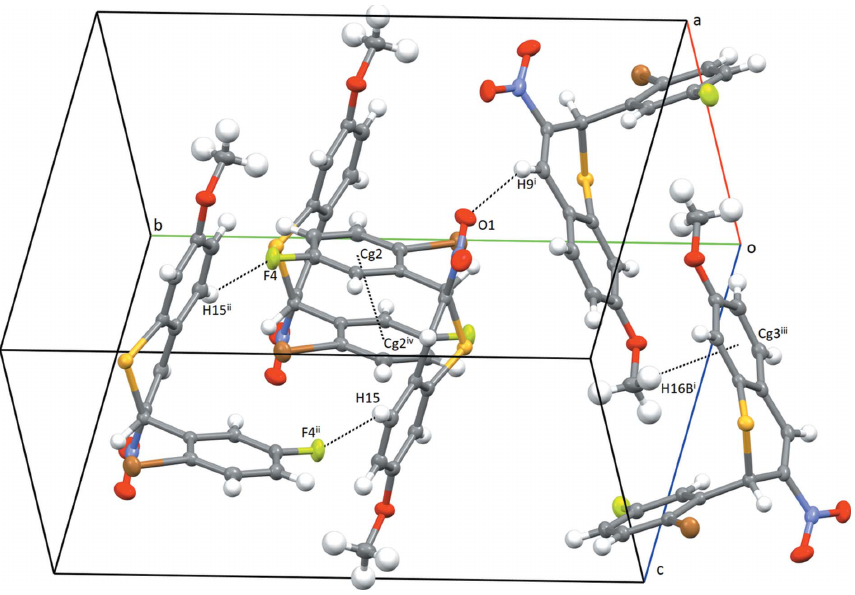
Figure 4 Packing diagram for B , showing C—H (cid:2)(cid:2)(cid:2) O, C—H (cid:2)(cid:2)(cid:2) F, C—H (cid:2)(cid:2)(cid:2) (cid:2) and (cid:2) – (cid:2) interactions [symmetry codes: (i) x , (cid:5) y + 1 , z (cid:5) 1 ; (ii) (cid:5) x + 2, (cid:5) y + 1, (cid:5) z + 2; 2 2 (iii) (cid:5) x + 1, y (cid:5) 1 , (cid:5) z + 3 ; (iv) (cid:5) x + 1, (cid:5) y + 1, (cid:5) z + 1]. Cg 2 and Cg 3 are the centroids of the C1–C6 and C10–C15 rings, respectively. 2 2 0.5111 (18) A˚ , (cid:3) = 118.2 (2) (cid:3) and ’ = 208.1 (3) (cid:3) for B ]. The lengths in compound B [1.232 (2) and 1.221 (2) A˚ ] are slightly C—S bond lengths are almost equal [C7—S1 = 1.828 (4) A˚ longer than those in compound A [both 1.219 (5) A˚ ]. The nitro and C11—S1 = 1.8307 (19) A˚ for A , and 1.758 (5) and 1.7574 (19) A˚ for B , respectively]. The C11—S1—C7 bond the torsion angle O2—N8—C8—C9 of 1.3 (7) (cid:3) in A and angle is 102.5 (2) (cid:3) in A and 100.47 (9) (cid:3) in B . The N—O bond 9.5 (3) (cid:3) in B . Table 3 Experimental details. A B Crystal data Chemical